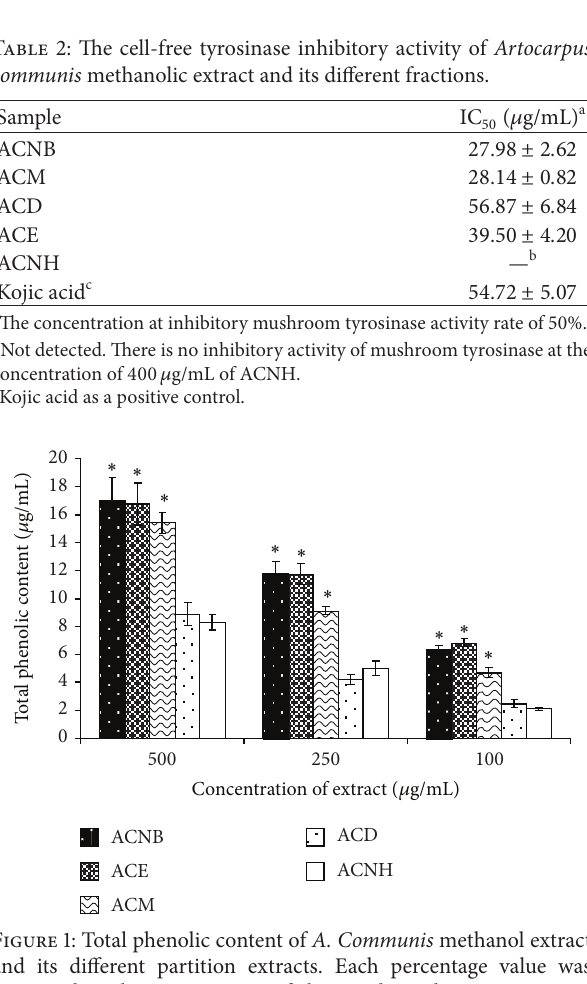
Figure 2: Effects of A. Communis extract and its different partition extracts on 𝛼 -MSH-induced cellular melanin content (a) and tyrosi- nase in B16F10 (b). Each percentage column for treated cells was shown to be relative to that of control. The results have been shown as the means ± SD and are representative of three independent experiments. # 𝑃 < 0.05 indicates significant difference from control in the absence 10nM of 𝛼 -MSH; ∗ 𝑃 < 0.05 indicates significant difference from 𝛼 -MSH treatment